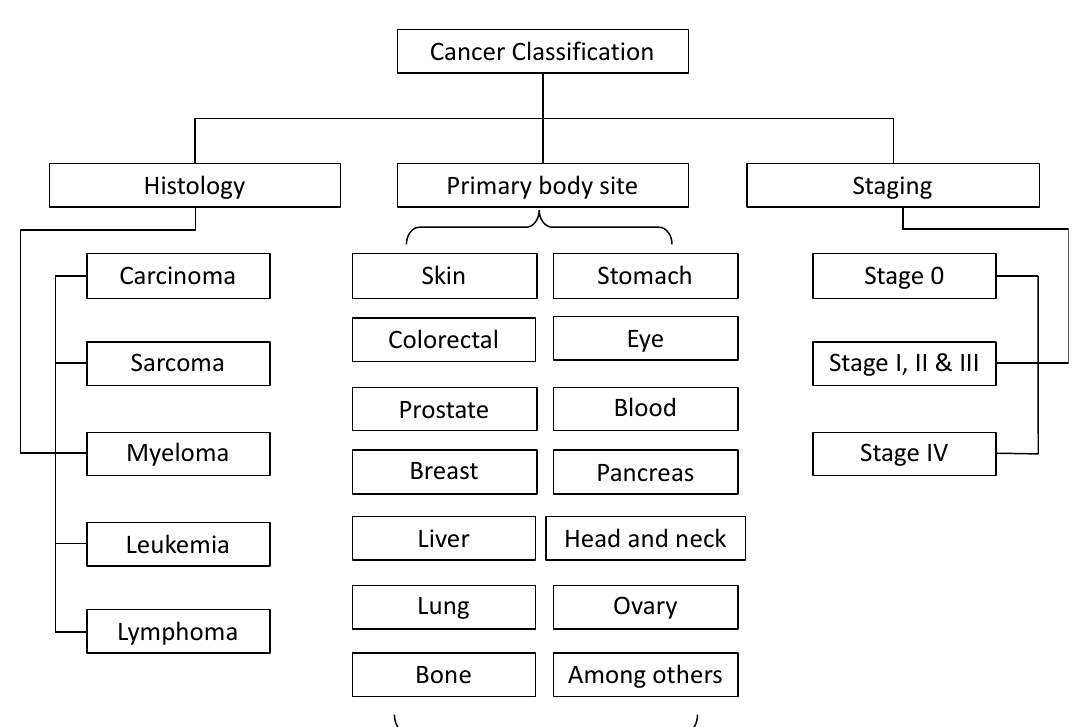
Figure 4. Traditionally cancer classification, histology, primary body site and staging.